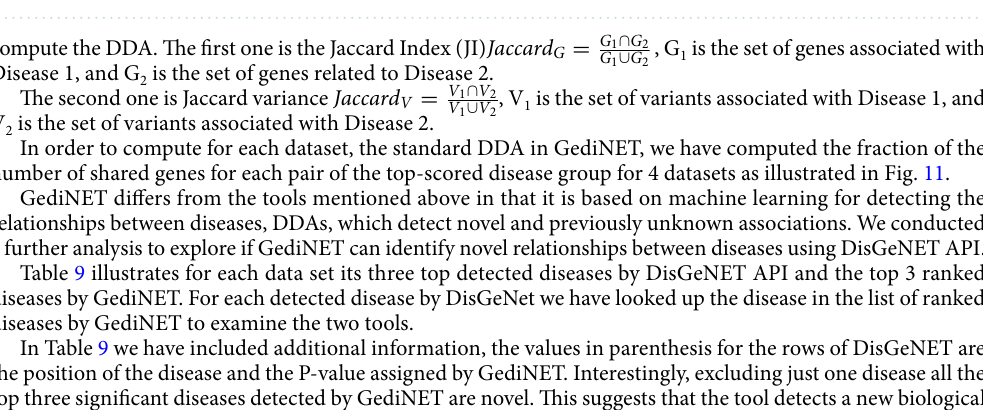
Figure 11. An example of the DDA for four datasets in GediNET. The number of shared genes for the top- scored disease group is represented. The upper panel shows the DDA for GDS1962, GDS3257, GDS2771 and GDS5499 datasets. The lower panel shows the annotations used in the DDA illustration